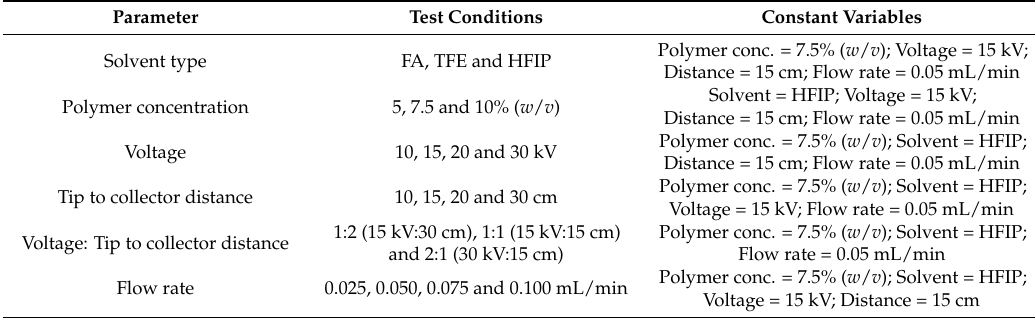
Table 1. Details of electrospinning parameters varied during